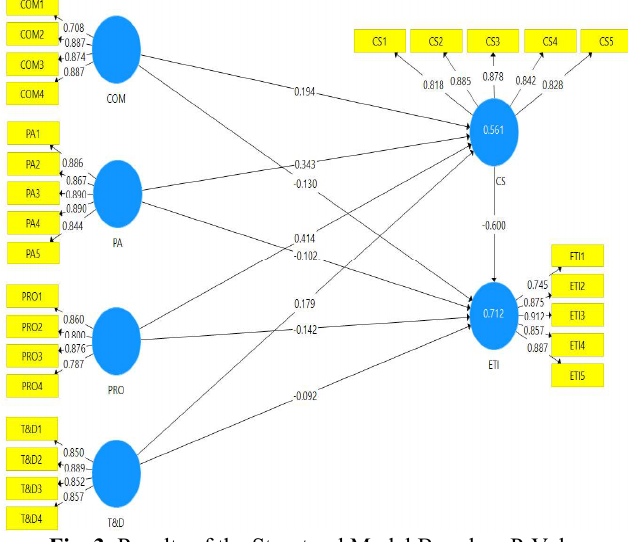
Fig. 3. Results of the Structural Model Based on